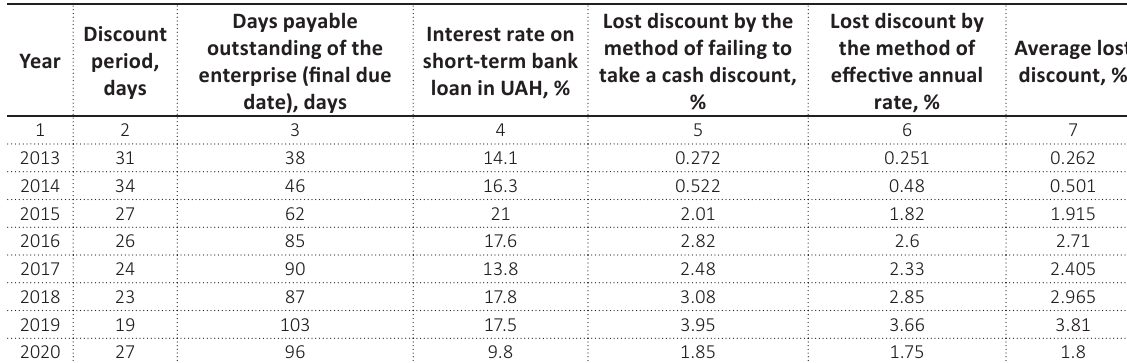
Table 3. Lost discount of Lagoda